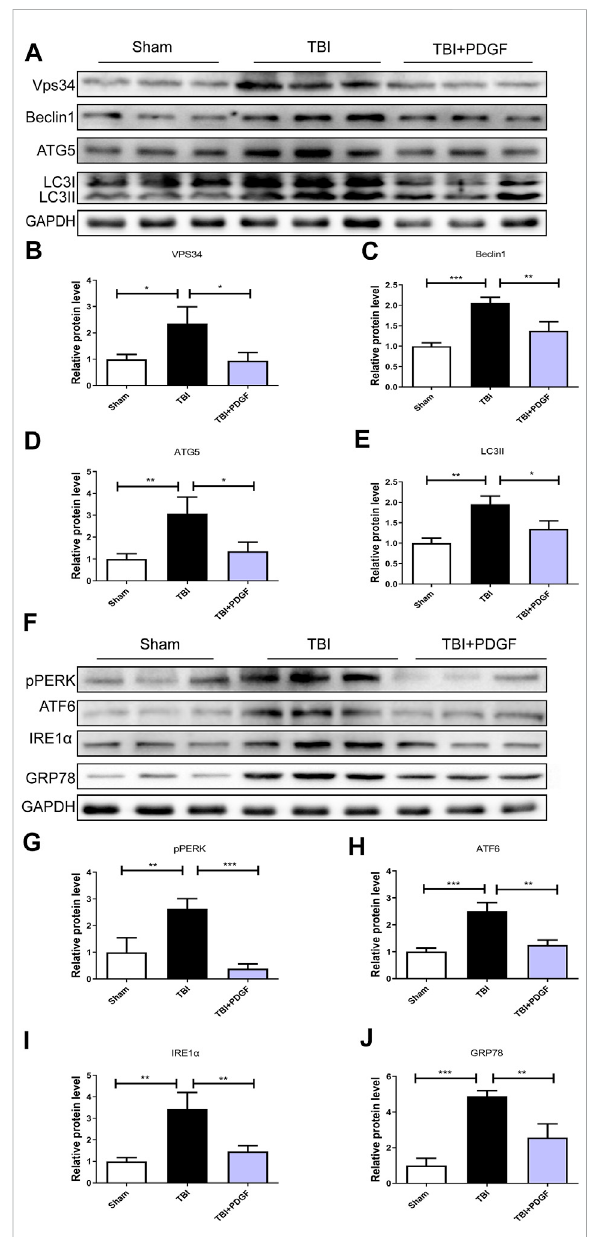
FIGURE 2 PDGF treatment signi fi cantly attenuates TBI-induced ER stress and autophagy. (A) Representative western blot analyses of VPS34, Beclin1, ATG5, and LC3I/II in the cerebral cortex at 3d after TBI. (B – E) Quanti fi cation of VPS34, Beclin1, ATG5, LC3II in the ipsilateral brain cortex at 3 days after TBI. Data represent the mean ± SD, n = 3, * p < 0.05, ** p < 0.01 and *** p < 0.001 vs. the indicated group. (F) Representative western blot analyses of pPERK, ATF6, IRE1 α and GRP78 in the cerebral cortex at 3 days afterTBI. (G – J) Quanti fi cationofpPERK,ATF6,IRE1 α andGRP78in the ipsilateral brain cortex at 3 days after TBI. Data represent the mean ± SD, n = 3, ** p < 0.01 and *** p < 0.001 vs. the indicated